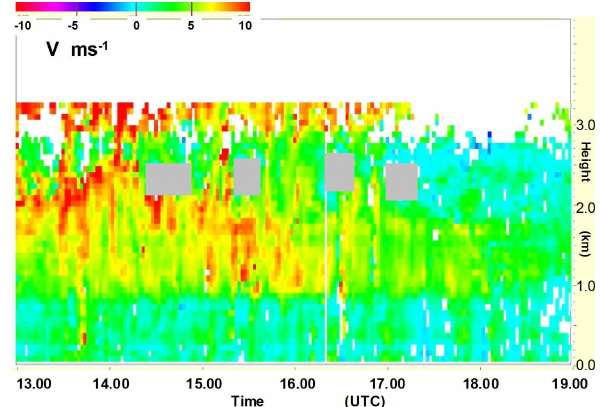
Fig. 13a. Range corrected signal to noise ratio measured by the wind profiler at Linkenholt 29 June 2005, 13:00–19:00UTC form 75 to 3000m a.g.l.